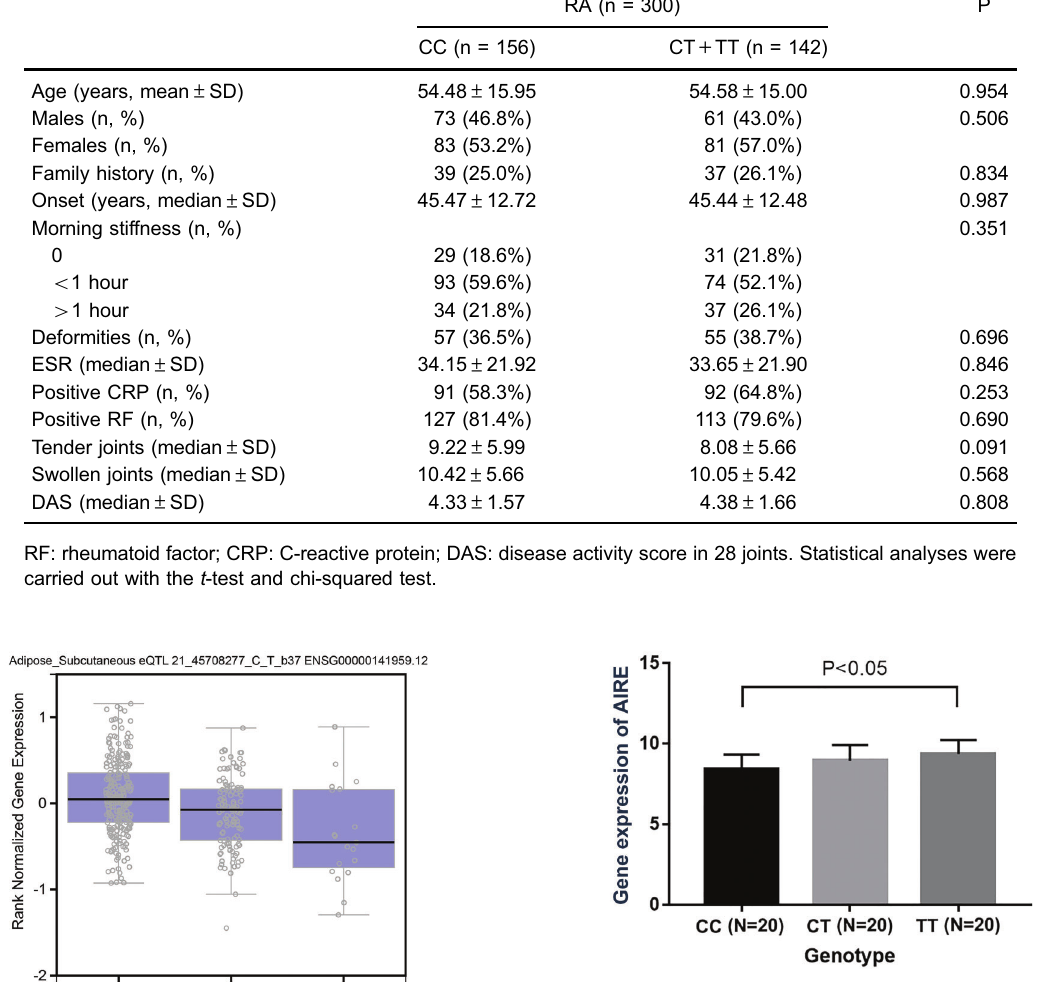
Figure 2. Expression levels of autoimmune regulator (AIRE). Data are reported as arbitrary units. P o 0.05 ( t